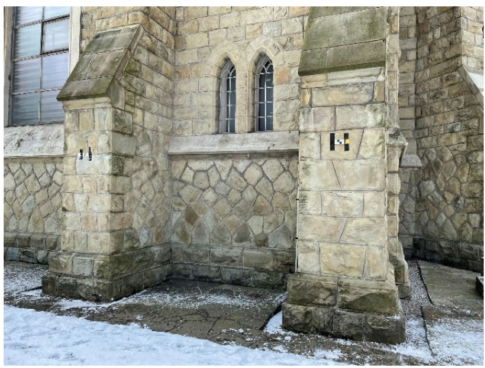
Figure 3. Fixing the warp points on the church buttresses.